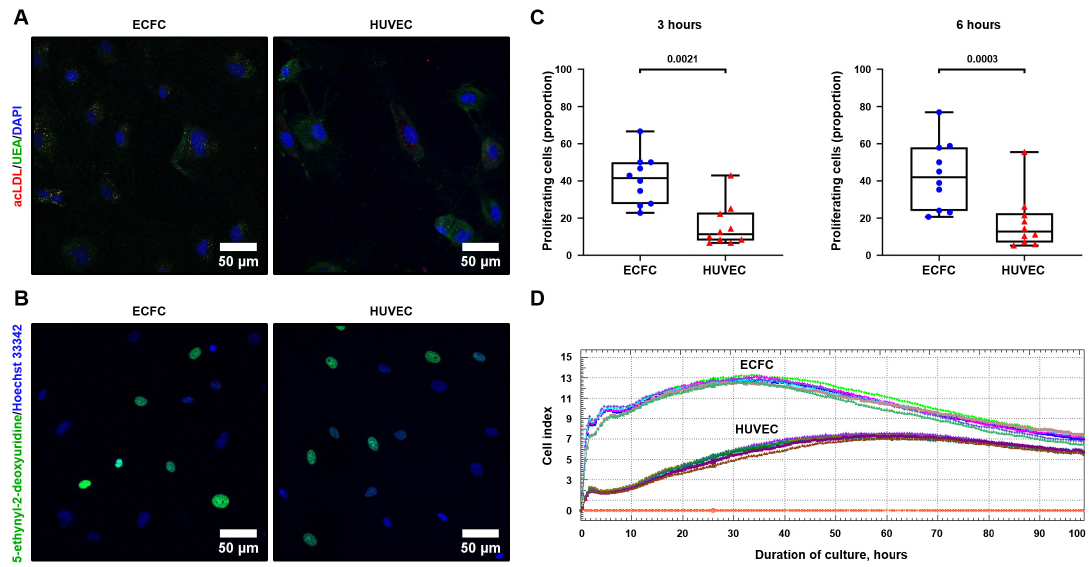
Figure 2. PBMC-derived ECFC internalize acetylated low-density lipoprotein cholesterol (acLDL), bind Ulex Europaeus agglutinin 1 (UEA), and exhibit high proliferation capacity. ( A ) Confocal microscopy (representative images) shows uptake of acLDL (red color inside the cytosol) and binding of UEA (green color around the cell membrane) by ECFC and HUVEC. Nuclear counterstaining was performed using DAPI (blue color); ( B ) A major proportion of ECFC and HUVEC are actively dividing as shown by 5-ethynyl-2-deoxyuridine incorporation into their nuclei (Hoechst 33342, blue). Representative images; ( C ) Semi-quantitative analysis of the proliferative activity from the experiment in B. Each dot represents one representative image from one well of the culture plate ( n = 10 wells per group). Whiskers indicate range, box bounds indicate 25th and 75th percentiles, center lines indicate median. P values are provided above the graphs in a numerical manner according to Mann–Whitney U test; ( D ) Electrical impedance monitoring in ECFC and HUVEC cultures confirms the results from confocal microscopy. Proliferation capability was defined as cell index doubling time calculated automatically by the instrument software. Each line represents a result collected from one well of the culture plate ( n = 7 per group). Red lines at the bottom indicate impedance of the blank solution (cell-free culture medium).